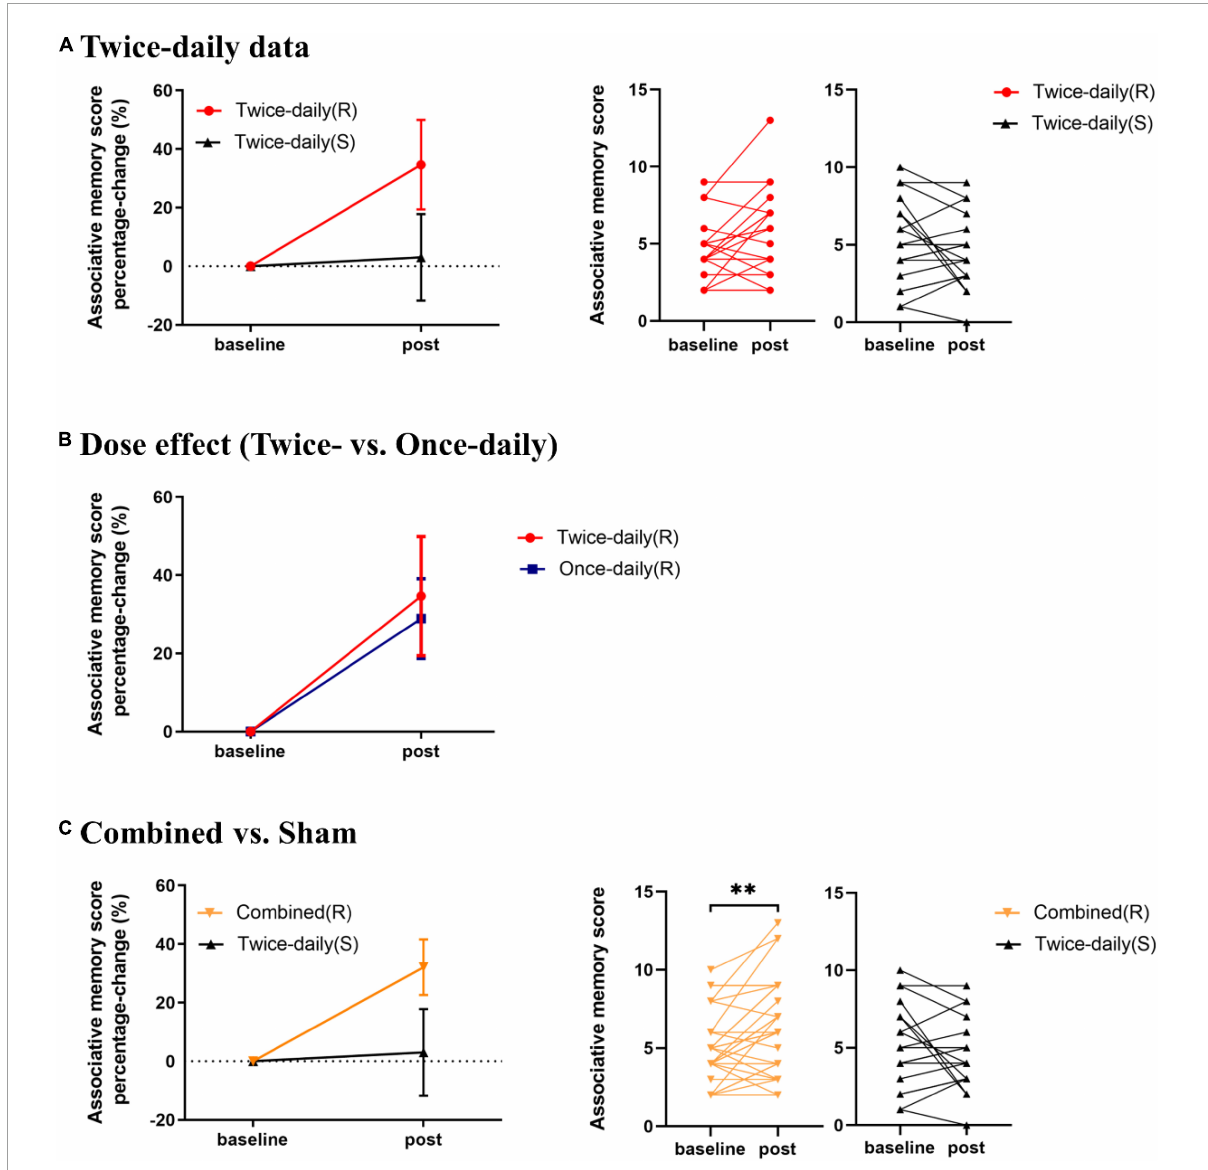
FIGURE2 Effects of rTMS on associative memory performance. (A) Mean percentage change in AM score from baseline for Twice-daily(R) and Twice-daily(S) groups. The interaction effect was significant, but post hoc analyses indicated no significant increase following real or sham stimulation. (B) Mean percentage change in AM score from baseline for Twice-daily(R) and Once-daily(R) groups. There was no significant Group × Time interaction. (C) Mean percentage change in AM score for Combined(R) and Twice-daily(S) groups. A significant Group × Time interaction was found, and post hoc analyses indicated that real rTMS but not sham rTMS significantly improved AM score compared to baseline. AM score Percentage-change = (post correct – baseline correct)/baseline correct × 100% . Error bars indicate SEM, ∗∗ P <